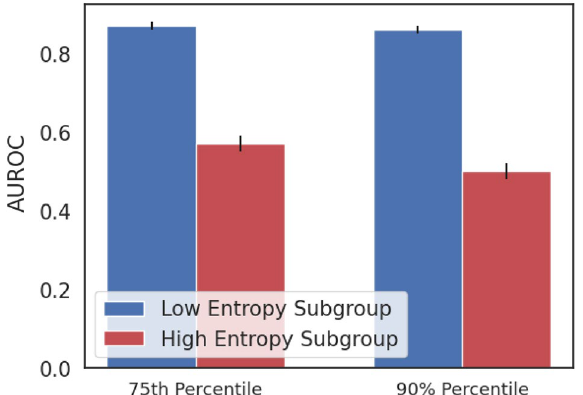
Figure 2. Performance stratified by entropy-based uncertainty score, showing mean and standard deviation over 10 bootstraps. HFNet performance is improved in cohorts with low uncertainty.